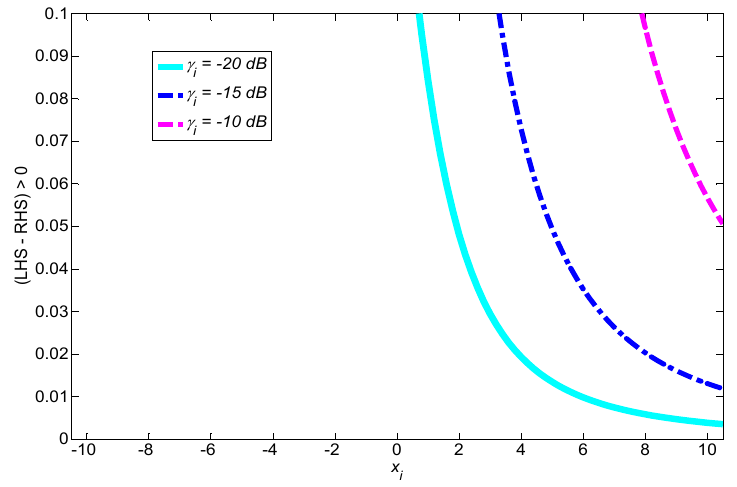
Figure 5. Inequality condition (9) in Proposition 1 holds for practical operating